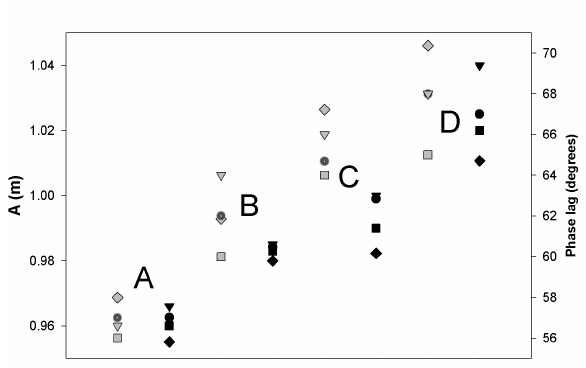
F IG . 3. – Amplitudes (black) and phase lags (grey) of the M2 tidal wave elevations from the numerical model at the stations of Sancti Petri (A), Gallineras (B), Iro (C) and Zaporito (D) for Cd=0.002 (square), Cd=0.003 (circle), Cd=0.004 (upside down triangle). Results for the observed data sets are presented with